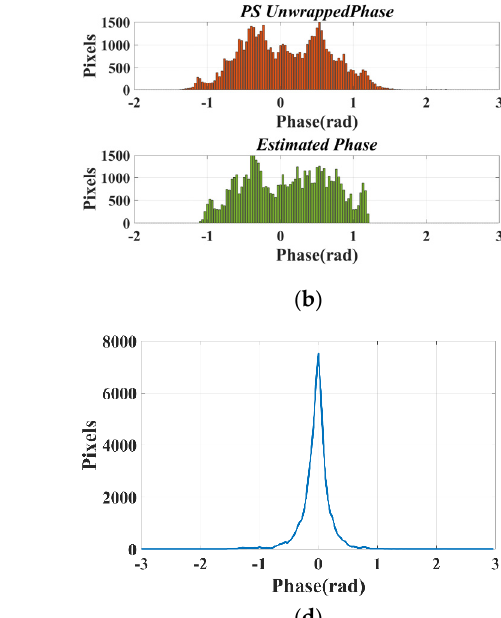
Figure 11. Results of error phase compensation in IM 1 : ( a ) Unwrapped phase map (Before compensation); ( b ) Corresponding histograms; ( c ) Compensated phase map; ( d ) Phase distribution curve.